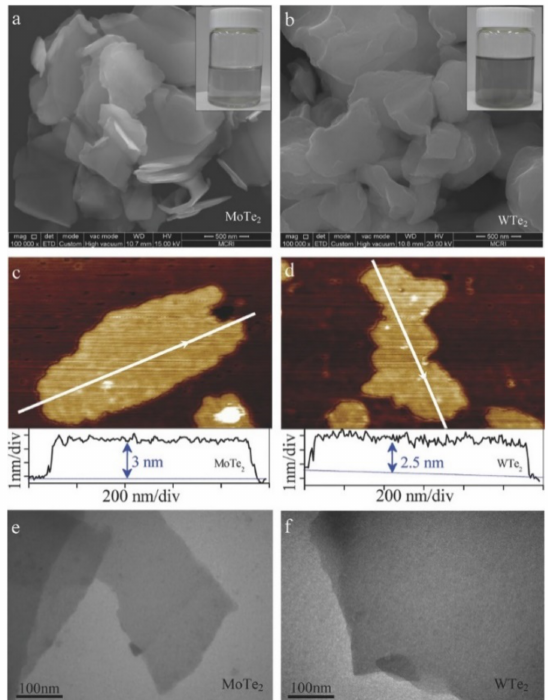
Figure 3. Characterization of MoTe 2 /WTe 2 nanosheets: ( a , b ) SEM image; ( c , d ) AFM image and ( e , f ) TEM image. The inset shows the corresponding suspension of the nanosheets. Reprinted with permission from